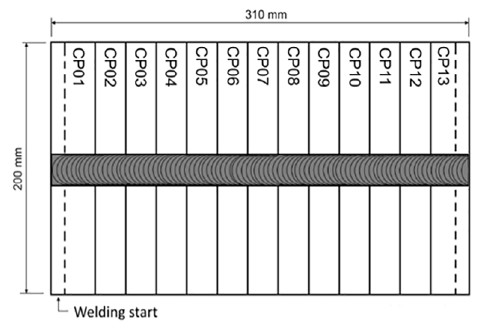
Figure 3. Specimens distribution along the welds.